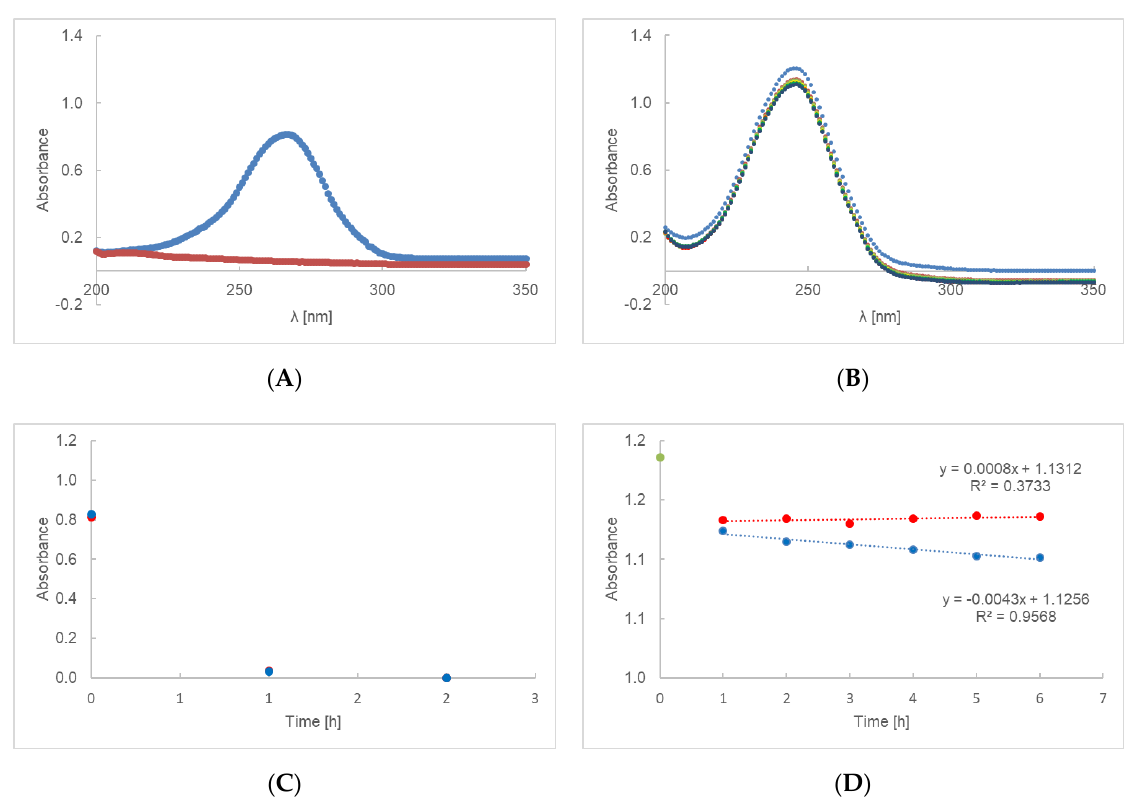
Figure 3. UV-Vis spectra of preparation AA-MC ( A ) and AE-MC ( B ), irradiated at 0( – ), 1( – ),2( – ), 3( – ), 4( – ), 5( – ) and 6( – ) h. The UV degradation gel containing PA and ascorbic acid ( C ), or ethyl ascorbic acid ( D ), presented as time function of absorbance. Red dots represent unexposed samples and blue dots represent irradiated samples. During the first hour, the specimen stabilizes — green dot represents the starting point of the procedure on ( D ) graph.